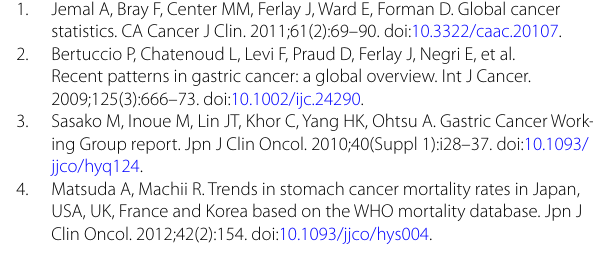
RFS recurrence-free survival, Incidence incidence of anastomotic leakage or pancreatic fistula, GC gastric cancer, LADG laparoscopy-assisted distal gastrectomy, ODG open distal